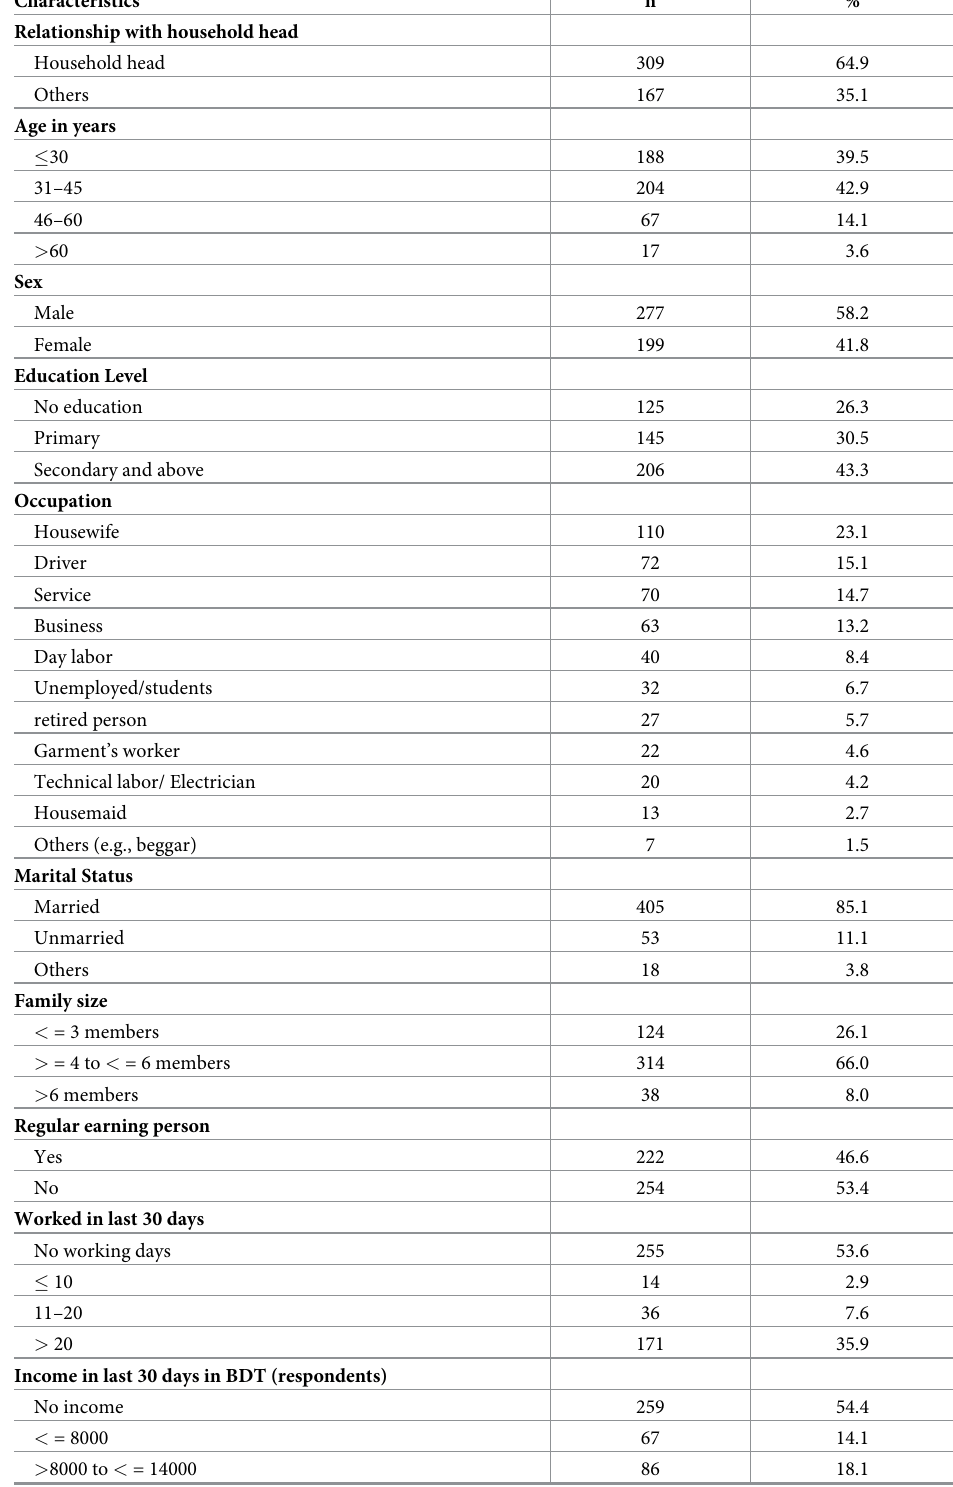
Table 1. Characteristics of the respondents and households (N =